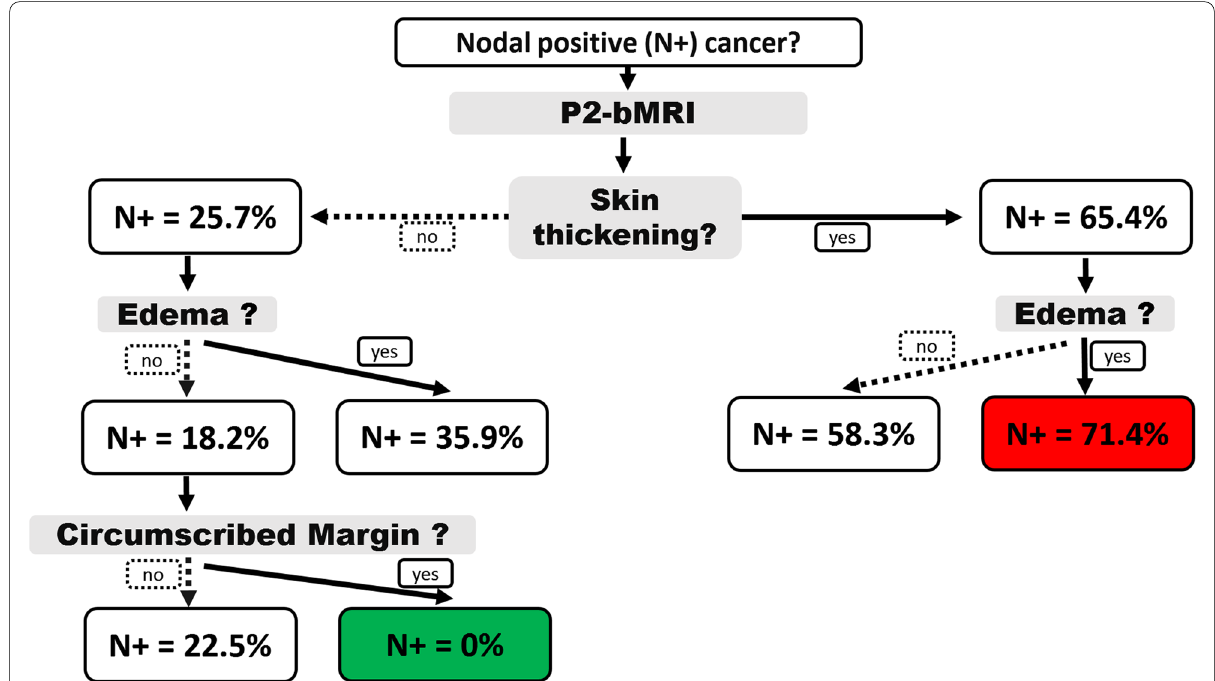
Fig. 8 P2‑bMRI phenotypes are imaging patterns highly specific of a distinct tumour biology. They may be used as rule‑in or rule‑out criteria for clinical decision‑making. Typically, P2‑bMRI phenotypes are based on the assessment of multiple criteria in concert as in this example: here, a machine learning algorithm was used to identify phenotypes predictive of nodal‑positive or nodal‑negative stage (N , N‑). Semantic imaging + criteria of the index lesion were used to predict nodal stage (for details, please see reference [42]). Classification results are presented as an intuitive and easy to follow decision tree. Accordingly, the “nodal‑negative P2‑bMRI phenotype” is characterised by a smooth lesion without oedema and without skin thickening. The positive likelihood of N is 0% for this P2‑bMRI phenotype. Similar results can be achieved with other predictive/ + prognostic MRI methods, including artificial intelligence, each of them providing intrinsic advantages and